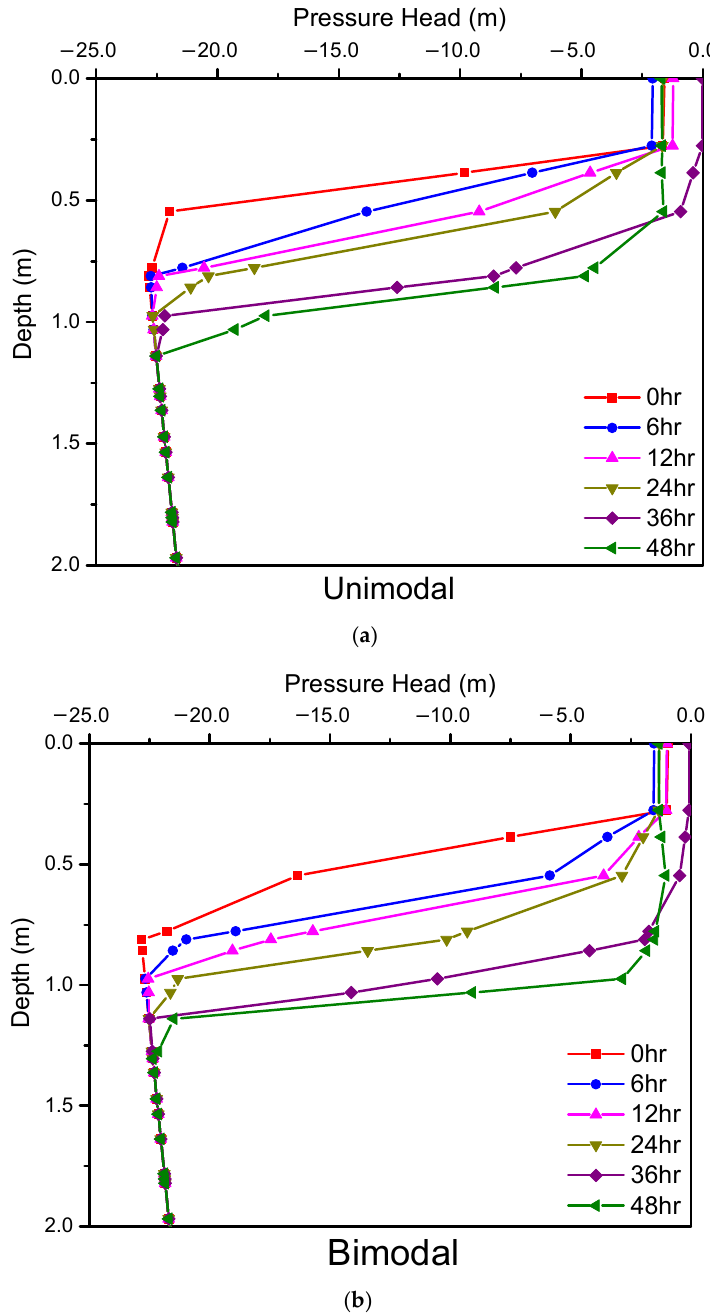
Figure 7. In the observation profile, the pressure head changes of ( a ) unimodal and ( b ) bimodal models at different times.